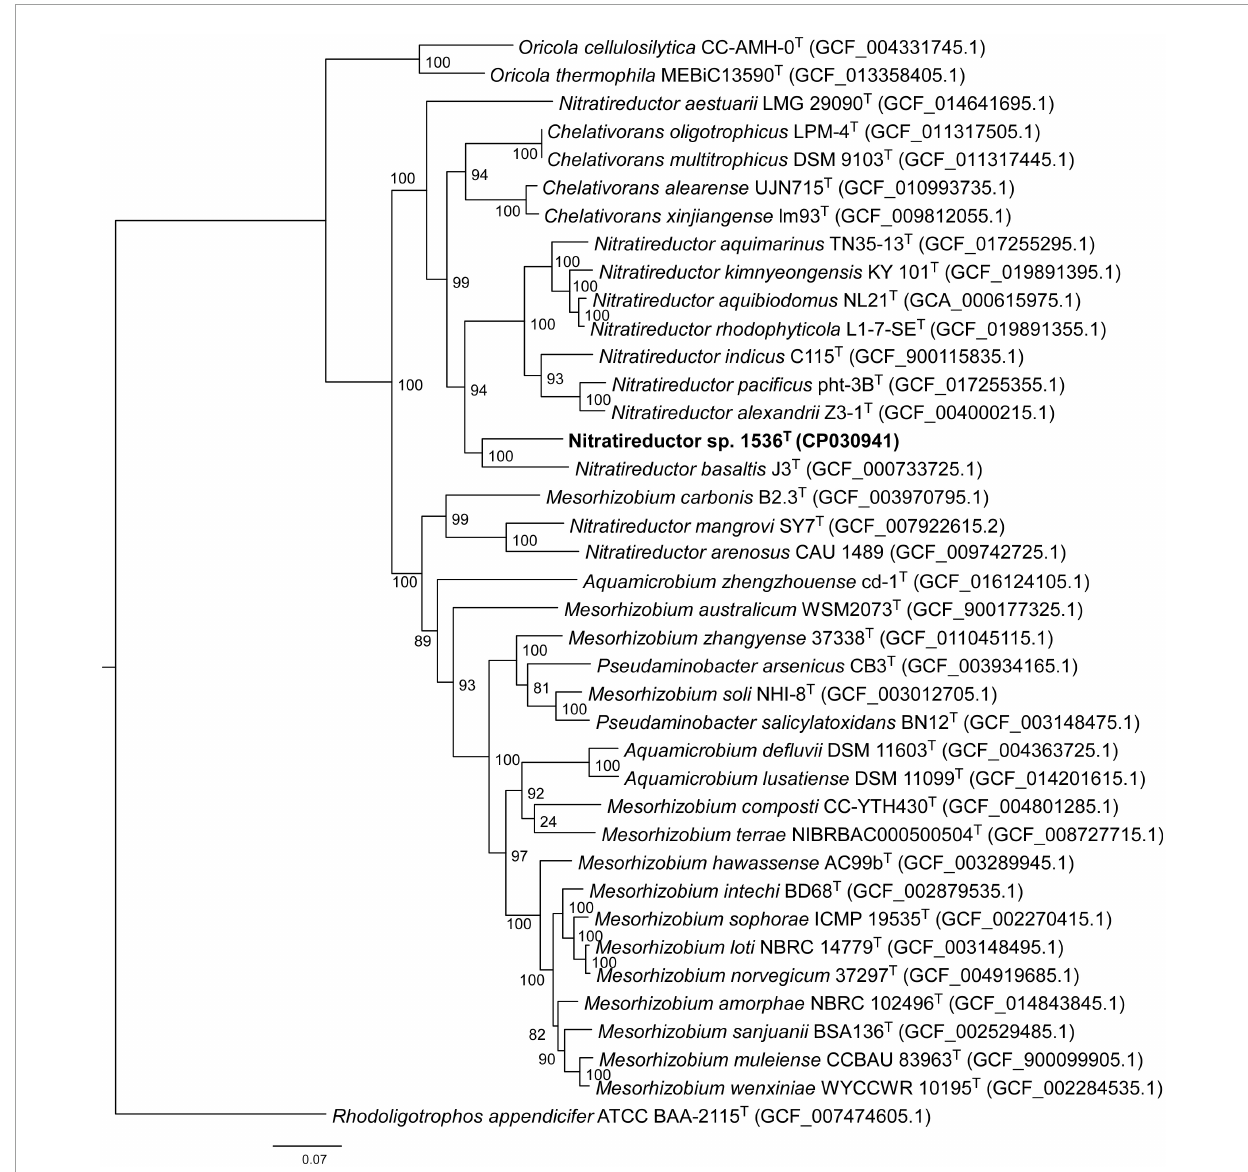
FIGURE3 Neighbor-joining phylogenomic tree using an MLSA concatenating 120 essential single-copy genes, highlighting the position of the Nit1536 T strain relative to other closely related bacterial taxa within the Phyllobacteriaceae family. The tree was reconstructed using the software GTDB-Tk (Chaumeil et al., 2019). Numbers at the nodes designate bootstrap support values resulting from 1,000 bootstrap replicates. Bar, 0.07 substitution per nucleotide position. Rhodoligotrophos appendicifer ATCC BAA-2115T (GCF_007474605.1) was used as an outgroup.